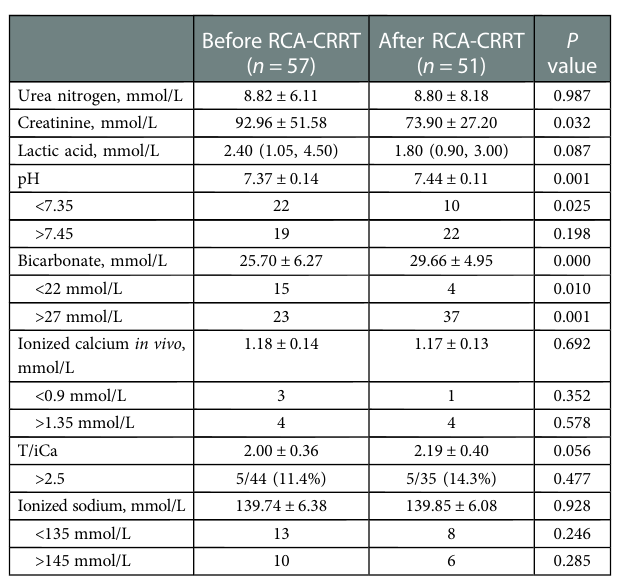
TABLE 2 Clinical characteristics of patients. TABLE 3 Comparison of blood gas analysis and biochemical indices before and after